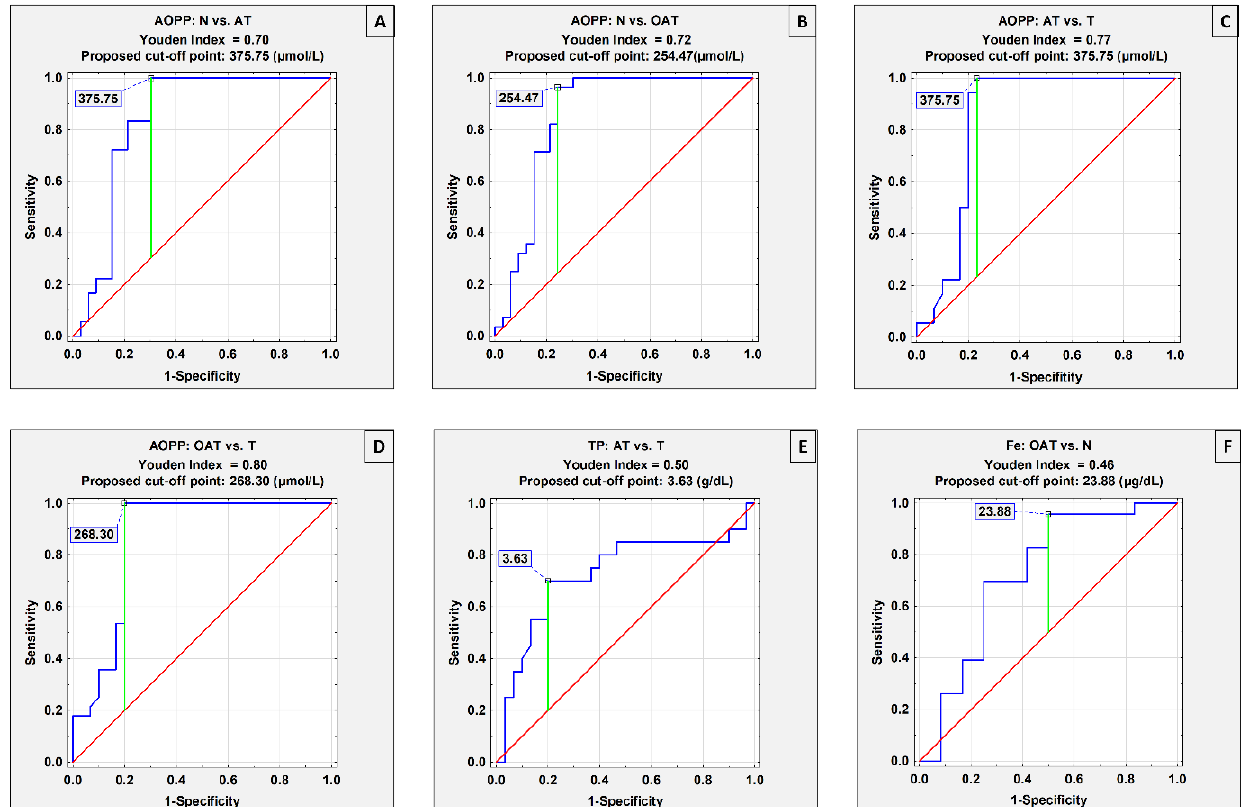
Figure 3. Receiver operating characteristic (ROC) curves for seminal plasma parameters with the area under the curve (AUC) equal to or higher than 0.725 ( A – F ). AOPP — advanced oxidation protein